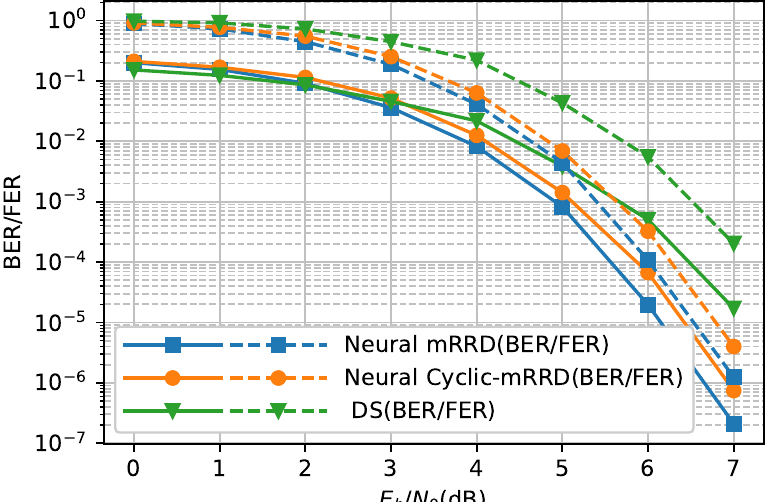
Figure 9. BER/FER performance of different decoders for the (71,36) QR code.